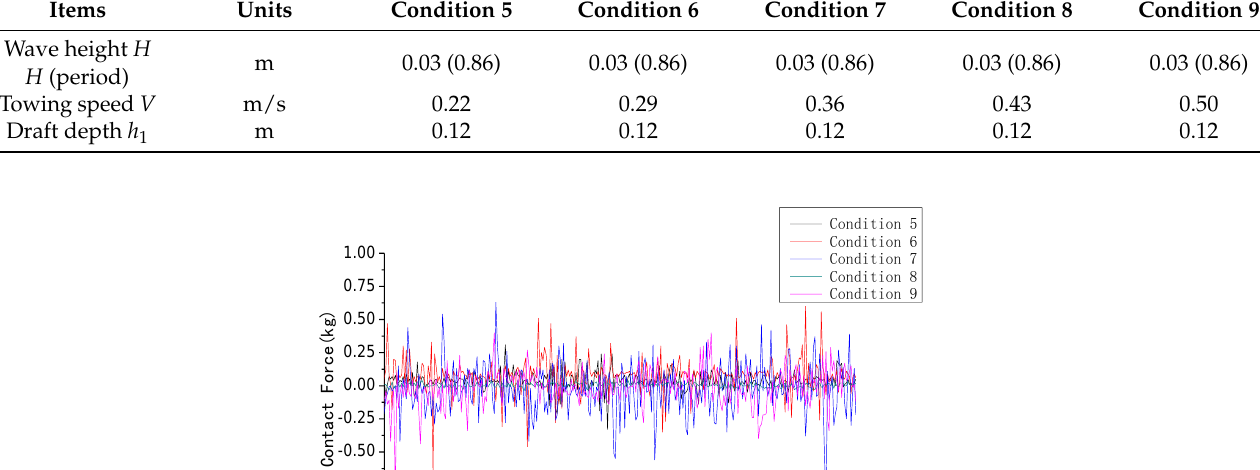
Figure 7. The curve of contact force vs. time considering wave height effect.